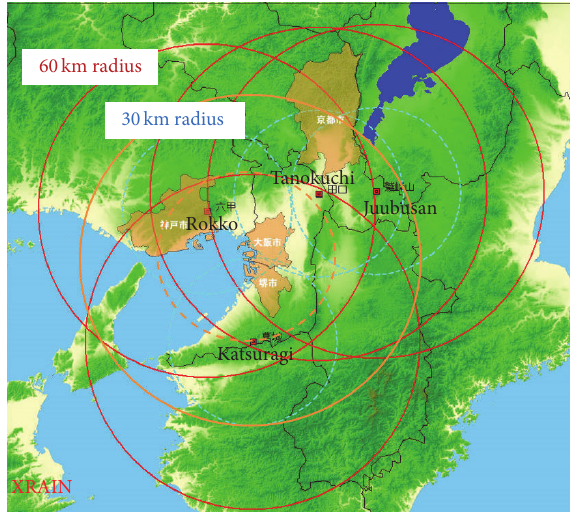
Figure 6: Four X-band radars in the Kinki